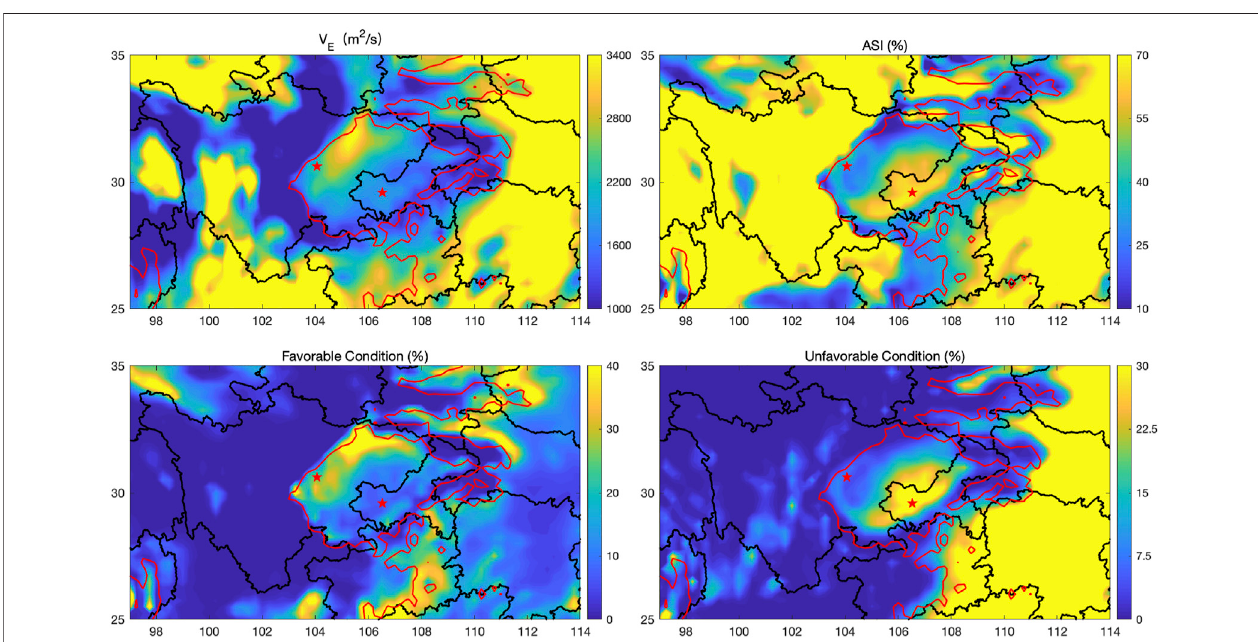
FIGURE4| Distributions ofventilationcoef fi cient(V E ),frequencyofairstagnation index(ASI),favorableconditionand unfavorable conditionduringthewintersfrom 1979 to 2019 in Sichuan Basin. Two red pentagrams indicate the locations of Chengdu and Chongqing.